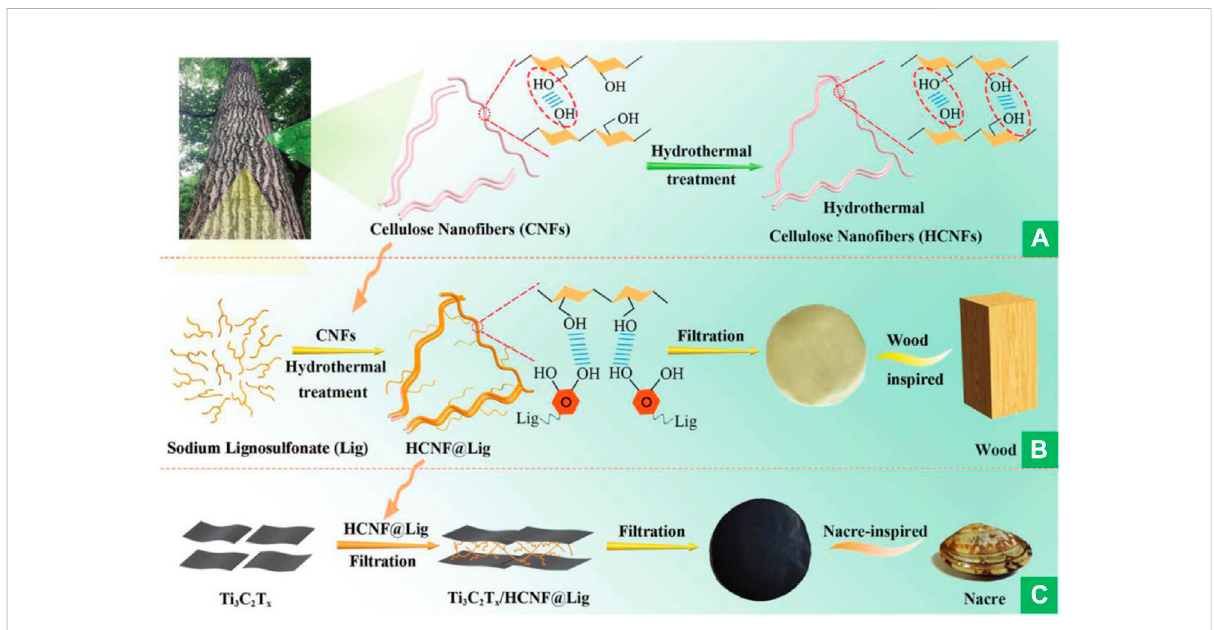
FIGURE 6 The preparation process of the nacre-inspired MXene/HCNF@Lig composite fi lms. Reproduced from: Chang et al. (2021), Royal Society of Chemistry.